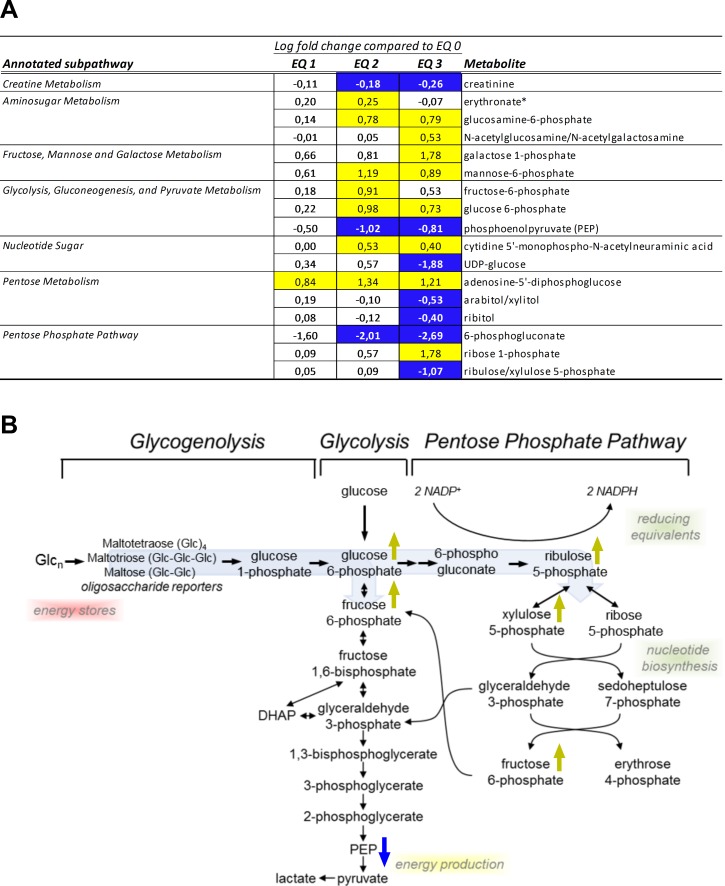
Alterations in liver creatinine levels and carbohydrate metabolism in livers of Atlantic salmon (Salmo salar L.) exposed to graded levels of ethoxyquin (EQ) through their diet for 90 days.(A) Metabolites displaying differential expression (p<0.05, ANOVA) were grouped according to subpathway annotations. Scaled intensity means were used to calculate log2 fold changes in the individual exposure groups compared to unexposed control animals (EQ 0). Significance of change was analyzed through pairwise comparisons between the individual exposure groups and the control, with colors denoting a significantly (p<0.05) increased (yellow) or decreased (blue) levels compared to the control. (B) Overview of selected significantly affected carbohydrate metabolites within the pathways of glycogenolysis, glycogenolysis and the pentose phosphate pathway. Metabolites significantly (p<0.05) affected by the increasing EQ levels are denoted with yellow (increase) or blue (decrease) arrows. See S4 Table for a complete overview of individual metabolites.